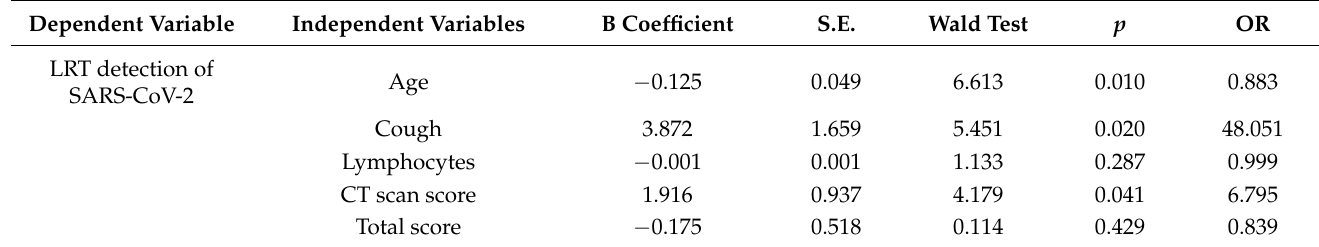
Table 5. Binomial logistic regression analysis of SARS-CoV-2 detection in